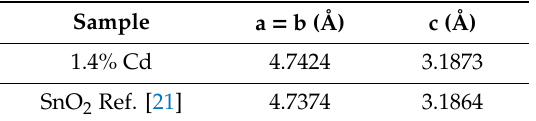
Table 1. Lattice parameters obtained from the XRD technique for pure SnO 2 samples [21] or doped with Cd by using the sol–gel